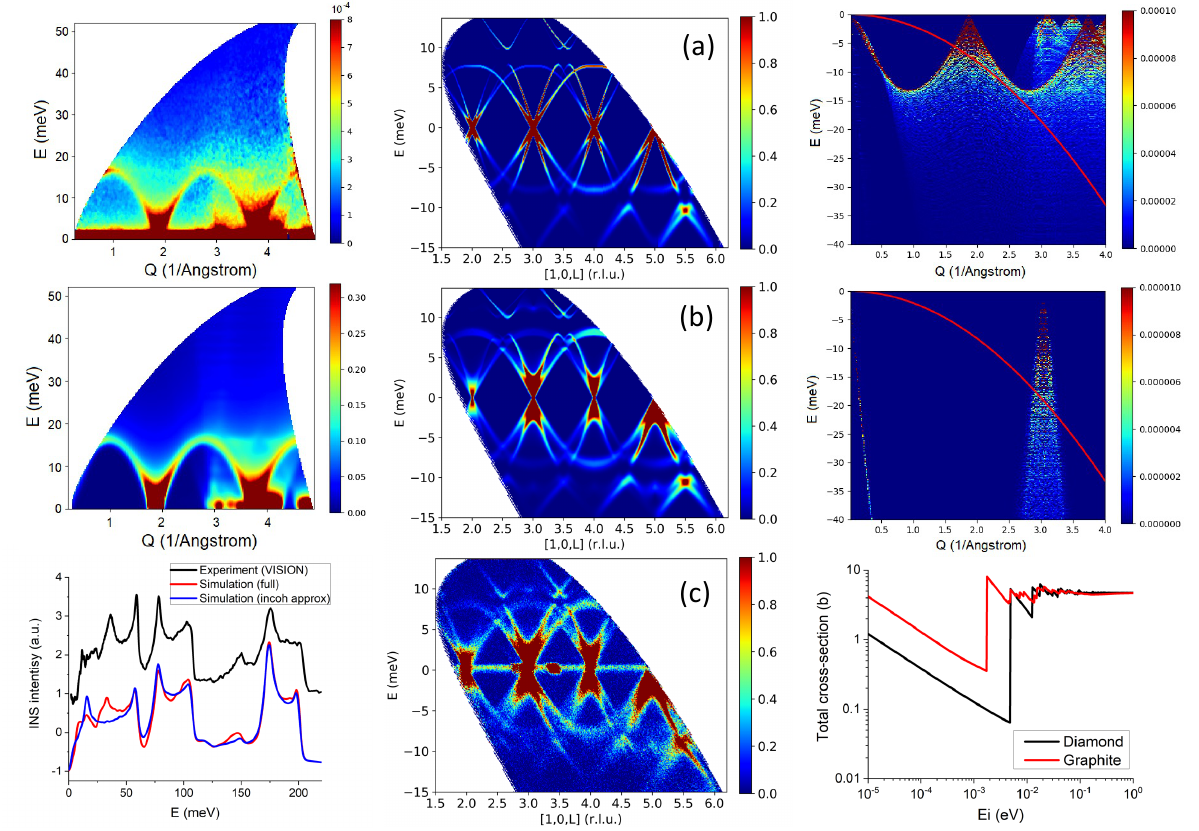
Figure 1. Examples of OCLIMAX applications. left column top and center, the S( Q ,ω ) map for graphite powder, bottom the INS spectra calculated for graphite along the VISION trajectory. Middle column, phonon dispersion along the [1, 0, L] transverse cut using the HYSPEC spectrometer [13]. DFT simulations (a) without integration and (b) with same integration and range as measured data in (c). (c) Measured INS data integrated at − 0 . 12 < ζ < 0 . 12 in (1 + ζ, 0 , 0) and − 0 . 12 < η < 0 . 12 in (1 ,η, 0). Right column, OCLIMAX calculation of the neutron energy gain part of the S( Q ,ω ) map for (top) graphite and (center) diamond. The red line indicates the trajectory where nearby phonons have major contributions to the scattering cross-section for low-energy ( < 1 meV ) neutrons. Note that to see the weak phonon excitations in diamond, the scale of the color bar for the right panel is only 1 / 10 of the left